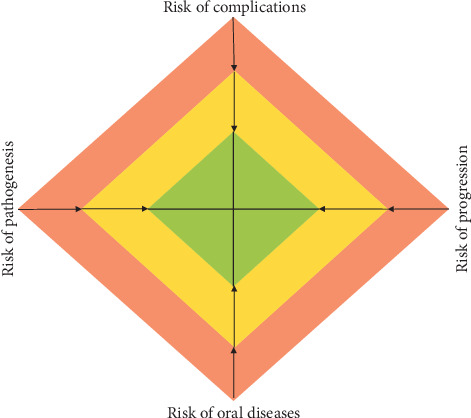
For each patient, an individual risk in the four domains can be evaluated. The vertical dimension can be seen as the “risk axis,” and the horizontal dimension describes the “need axis.” Based on these axes, the individual prevention regimen for each patient can be evaluated.